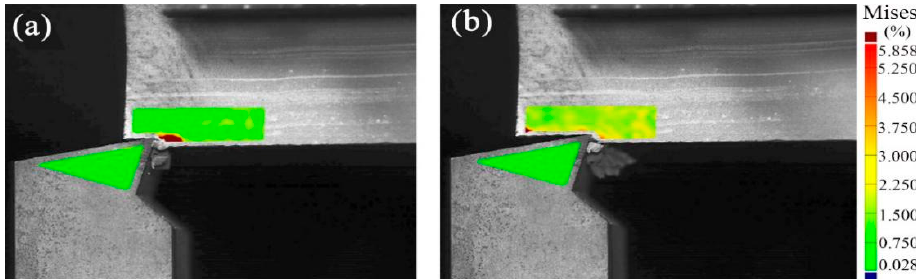
Figure 9. Full-field mechanics of SPC machining at moderate cutting depth of 1.1 mm: ( a ) The first captured stage; ( b ) the following capture